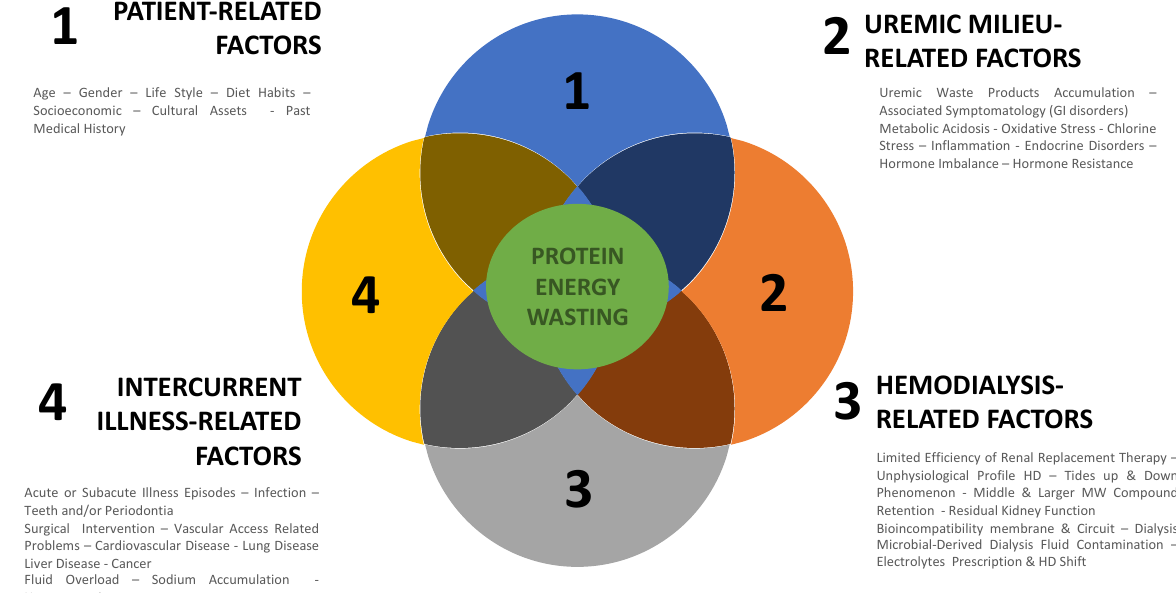
Figure 1. Causes of protein–energy malnutrition in dialysis patients.